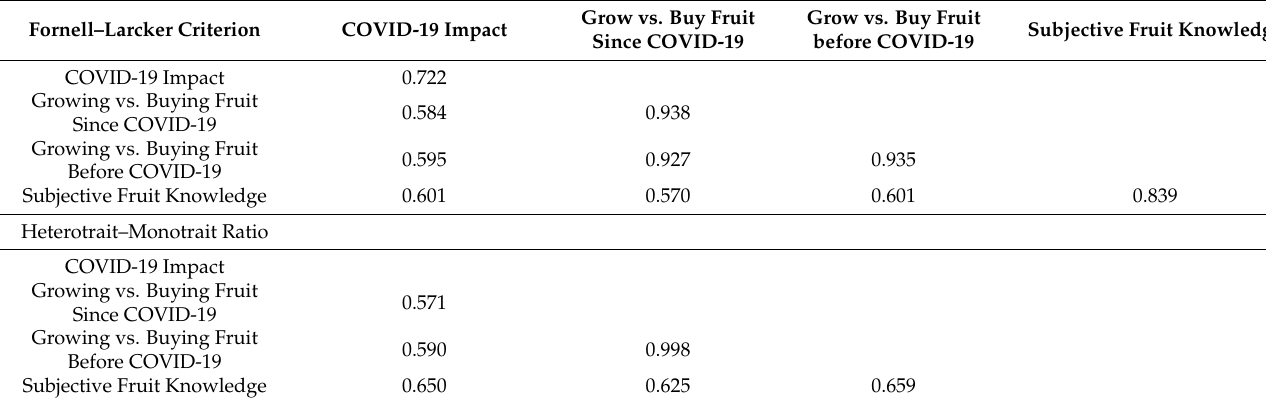
Table 3. Scale Discriminant